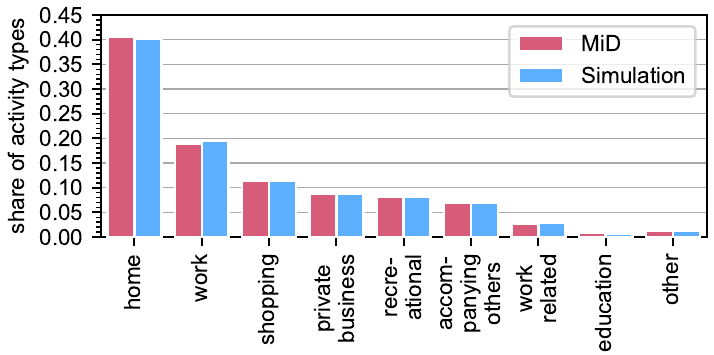
Figure 9. Share of activity types. Comparison of simulation and